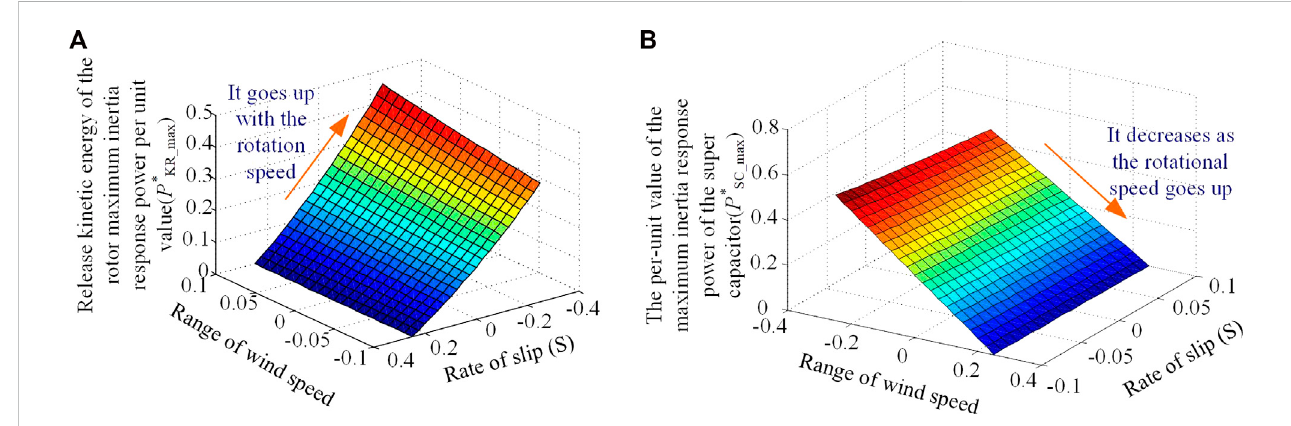
FIGURE 2 Investment cost under different wind storage coordination structures.